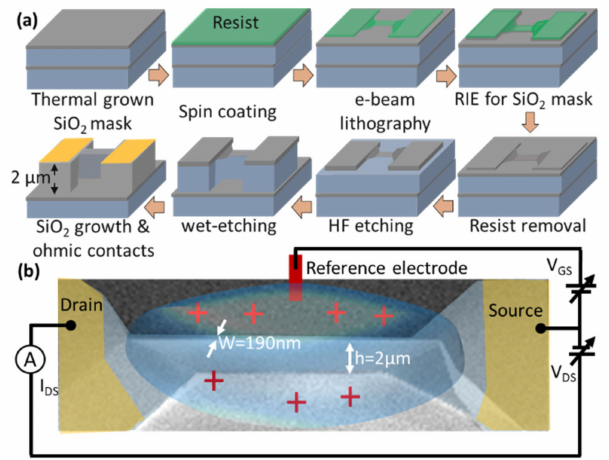
Figure 1. ( a ) Schematics of the process flow for the fabrication of Si Fin-field effect transistors (FETs). Silicon, SiO 2 , e-beam sensitive resist, and ohmic contacts are represented in light blue, grey, green and yellow, respectively. ( b ) Schematics illustrating operation of Si FinFET in liquid gate configuration.